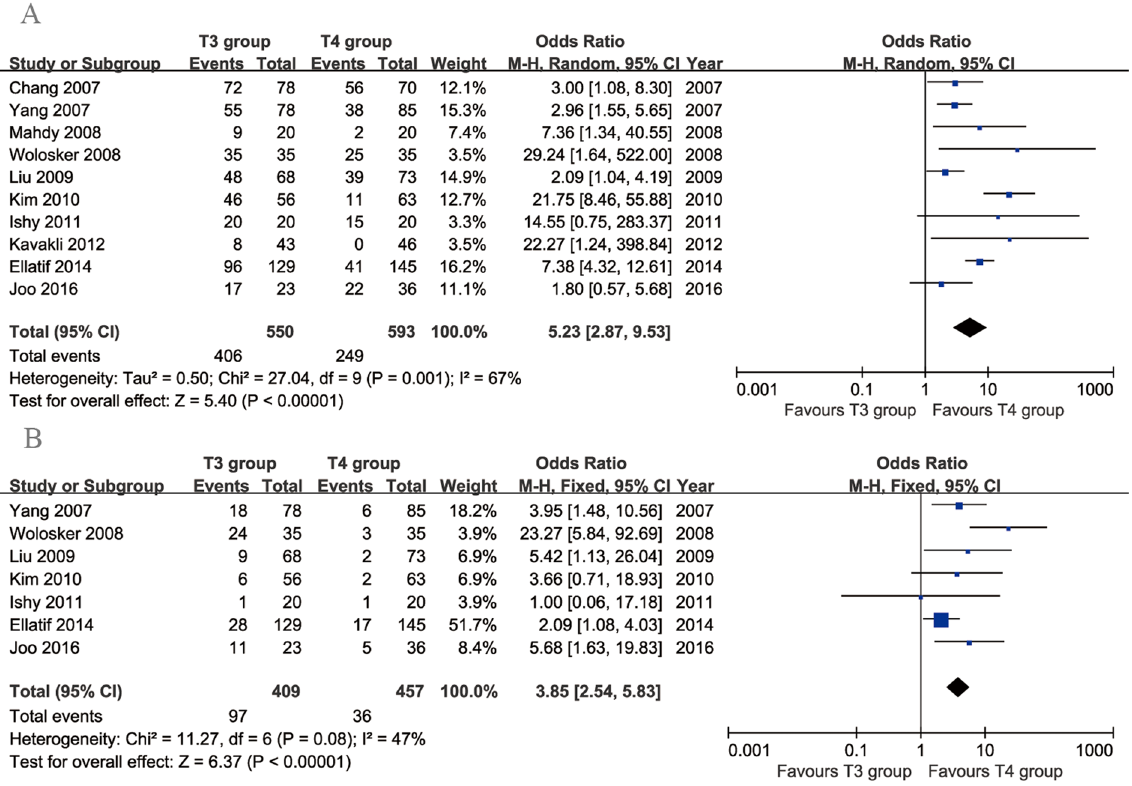
Figure 6. Forest plots for compensatory sweating ( A ) and moderate-to-severe compensatory sweating ( B ) in the T3 and T4